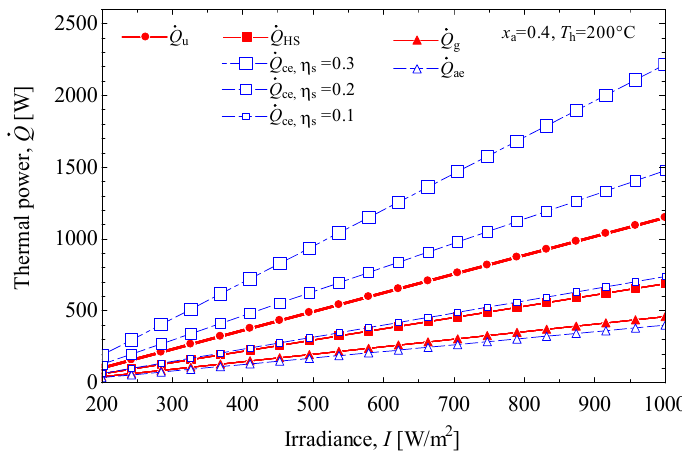
Figure 8. Thermal power produced by the solar concentrator and by absorption/compression refrigeration systems, with respect to solar radiation.